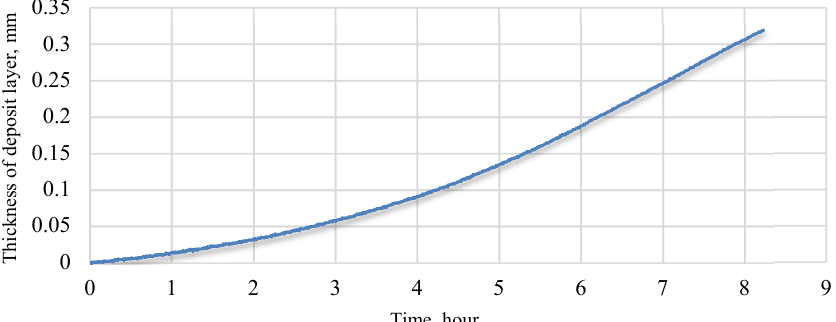
Figure 4. Dependences of the thickness of wax deposits on time.